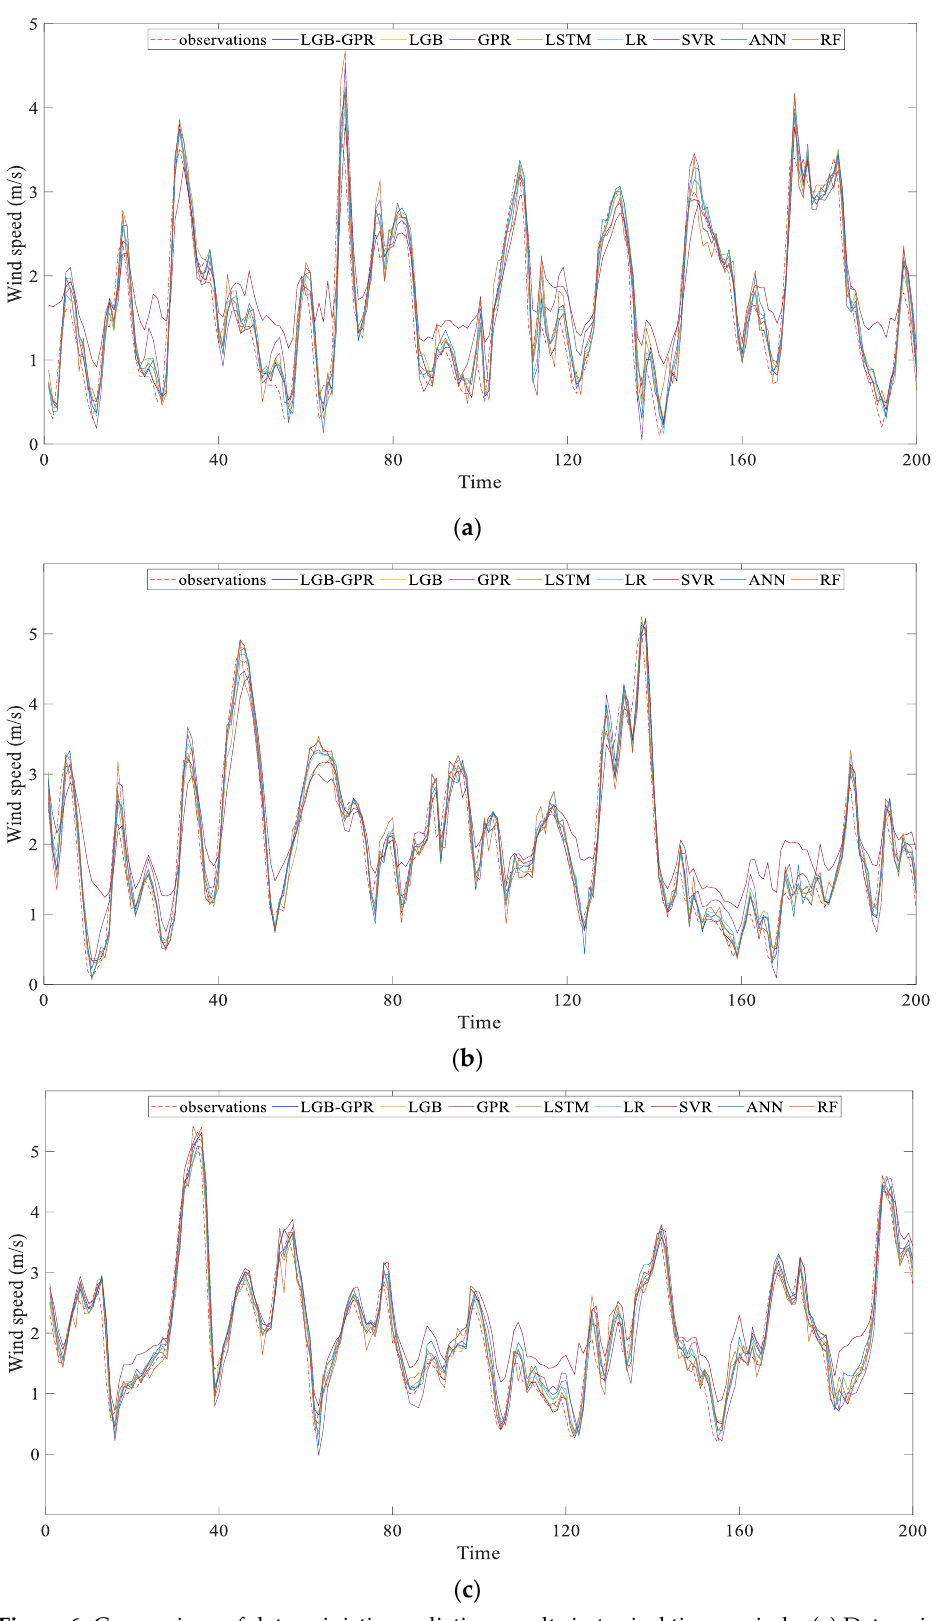
Figure 6. Comparison of deterministic prediction results in typical time periods: ( a ) Deterministic prediction results on dataset 1; ( b ) deterministic prediction results on dataset 2; ( c ) deterministic prediction results on dataset 3.